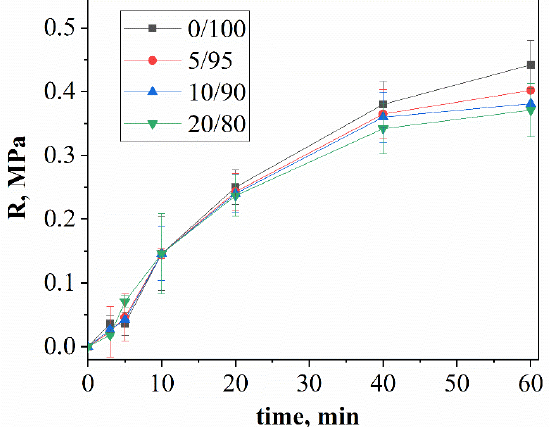
Figure 1. Figure 1. The time dependence of the plastic strength of cement stone with a weight ratio of: Ca(PO 3 ) 2 /Ca 2 P 2 O 7 = 0/100; Ca(PO 3 ) 2 /Ca 2 P 2 O 7 = 5/95; Ca(PO 3 ) 2 /Ca 2 P 2 O 7 = 10/90; Ca(PO 3 ) 2 /Ca 2 P 2 O 7 = 20/80. Ca(PO 3 ) 2 /Ca 2 P 2 O 7 = 20/80.